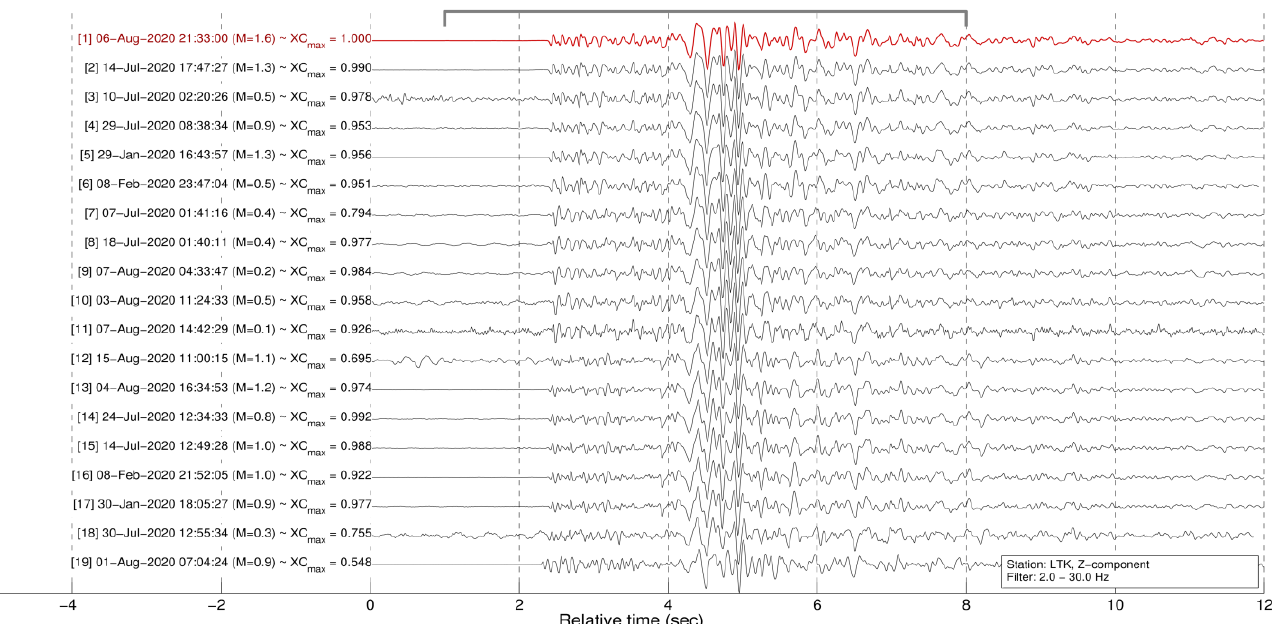
Figure A6. Waveforms of template “2020-07-04-02-02-37” (top, red) and 29 associated detections (black), belonging to multiplet #9 of CAT3, formed with farthest-neighbor linkage at a similarity threshold of 0.50 (see also Figure 10 for the temporal distribution of this multiplet). The recordings are from the vertical component of station LTK, filtered between 2 and 30 Hz. Note how the template matching method manages to detect the overlapping signal within the coda of a previous earthquake in waveform #15.